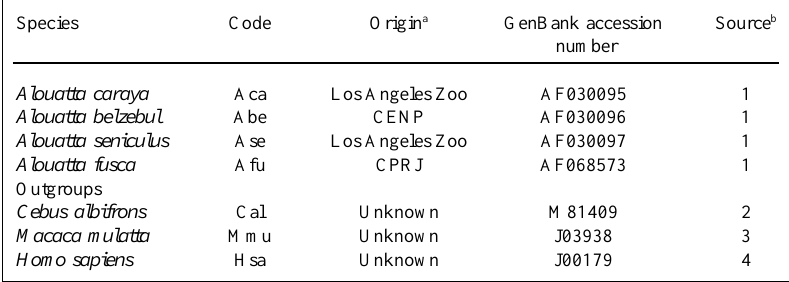
Table I - Code, origin and GenBank accession number for specimens analyzed in the present